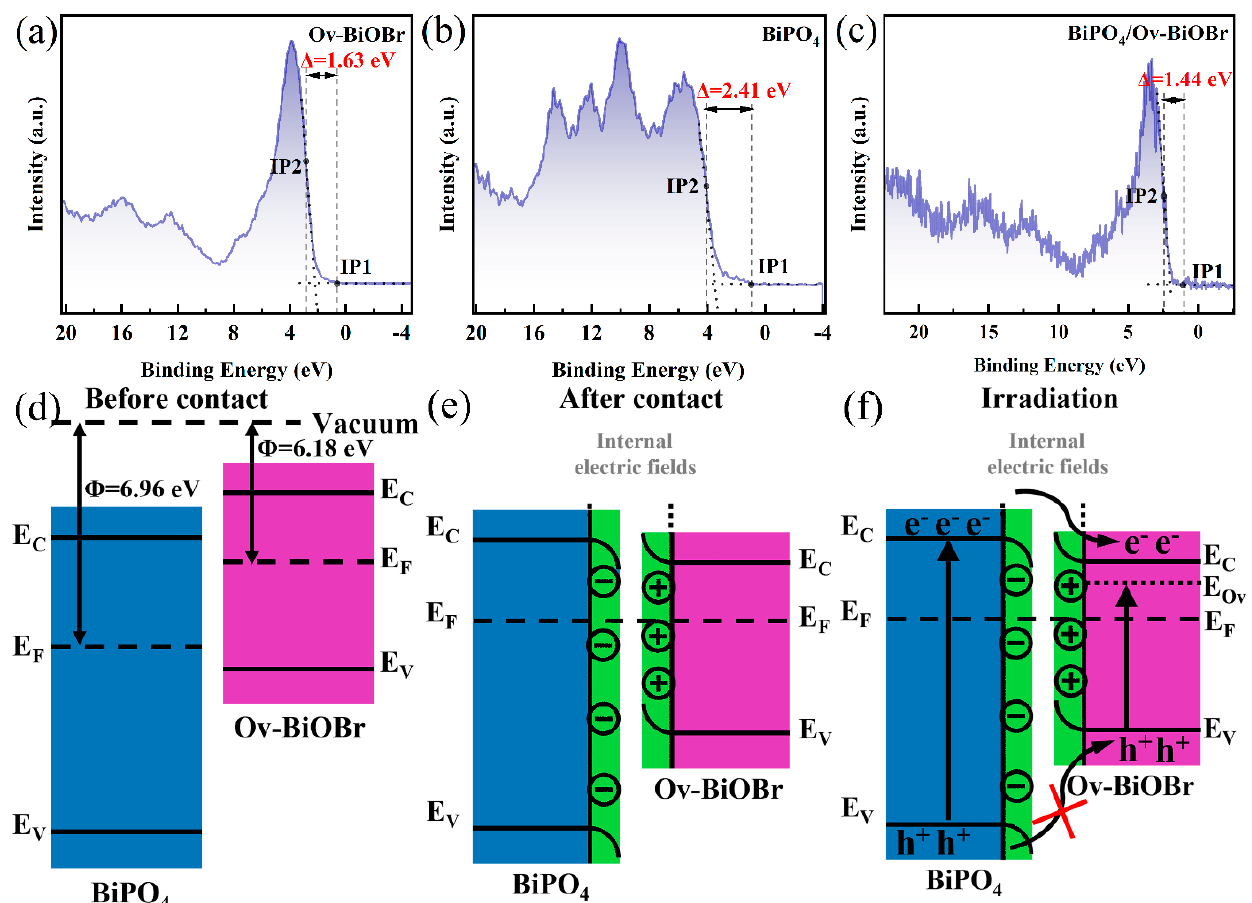
Figure 11. Work function of Ov-BiOBr, BiPO 4 and BiPO 4 /Ov-BiOBr ( a – c ), carrier transfer mechanism of BiPO 4 /Ov-BiOBr ( d – f ).